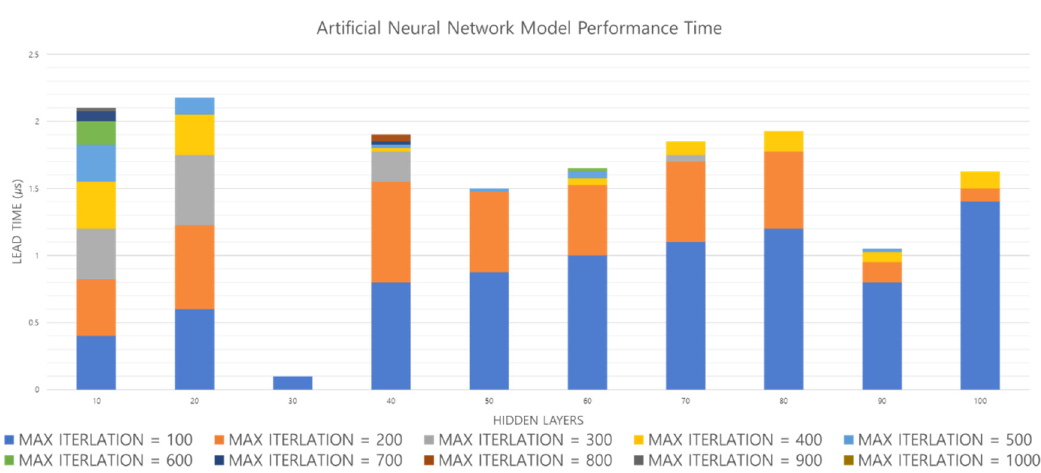
Figure 21. Performance evaluation of ANN model based on performance time.